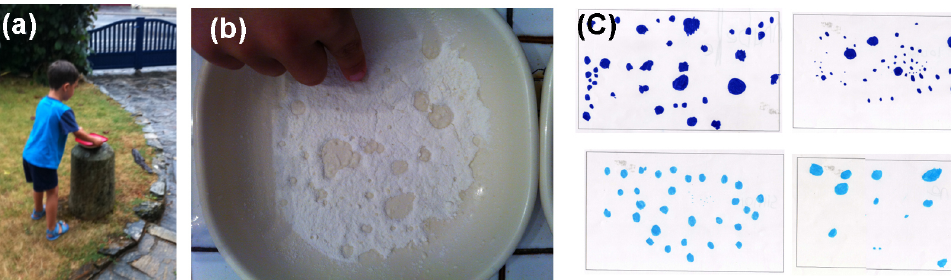
Figure 3. Use of the flour disdrometer in rainy conditions. (a) Experimenter bringing the device under rain and uncovering it for a few seconds. (b) Example of the outcome where the various sizes of drops are visible. (c) Drawings by the children of their